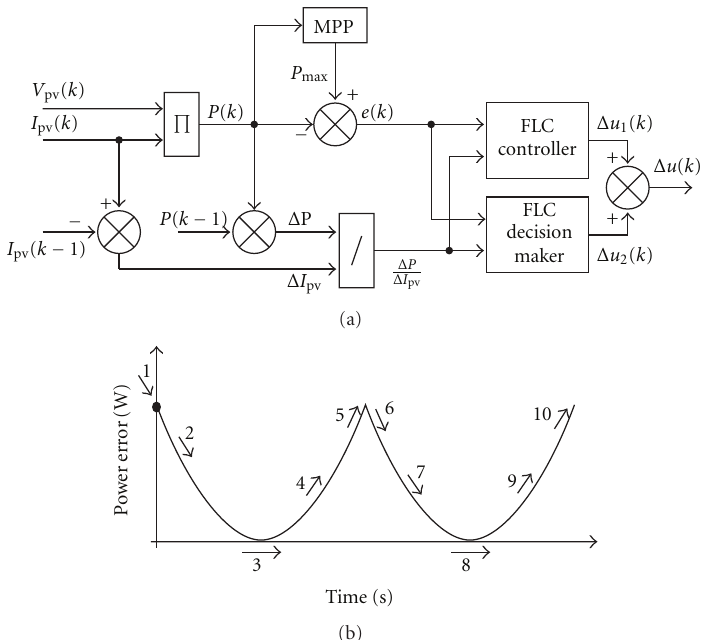
Figure 8: (a) Block diagram of dual FL MPPT algorithm and (b) power error changing of PV cells with time [35].